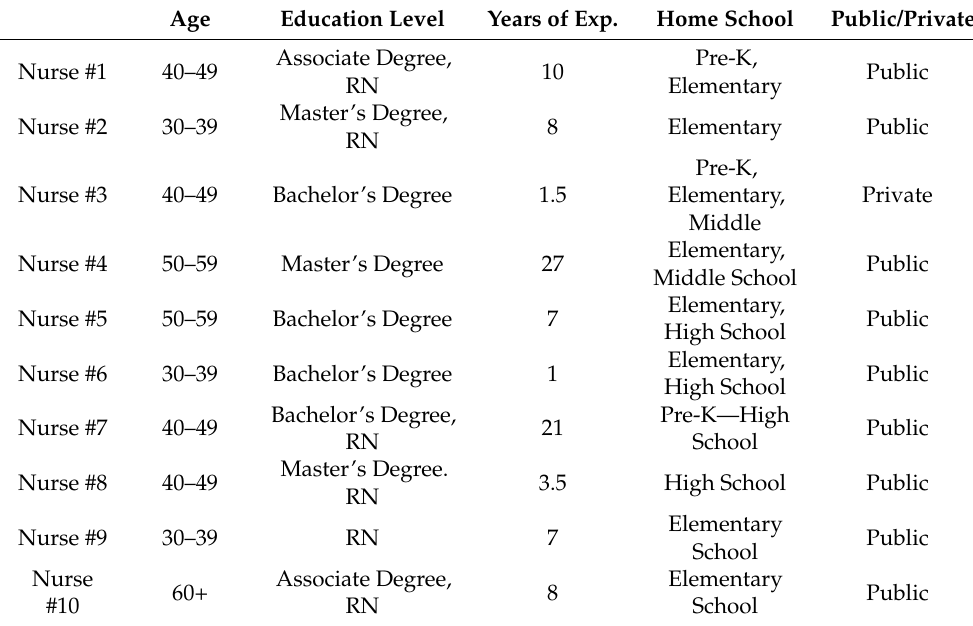
Table 1. Demographic characteristics of school nurse focus groups and interview